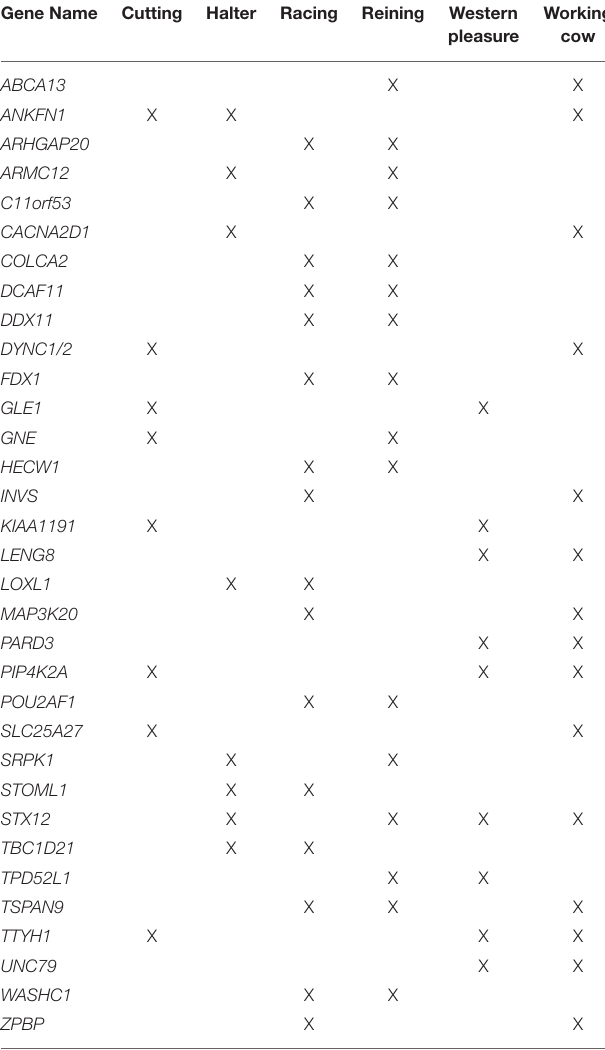
TABLE 5 | Genes undergoing selection in 2 or more